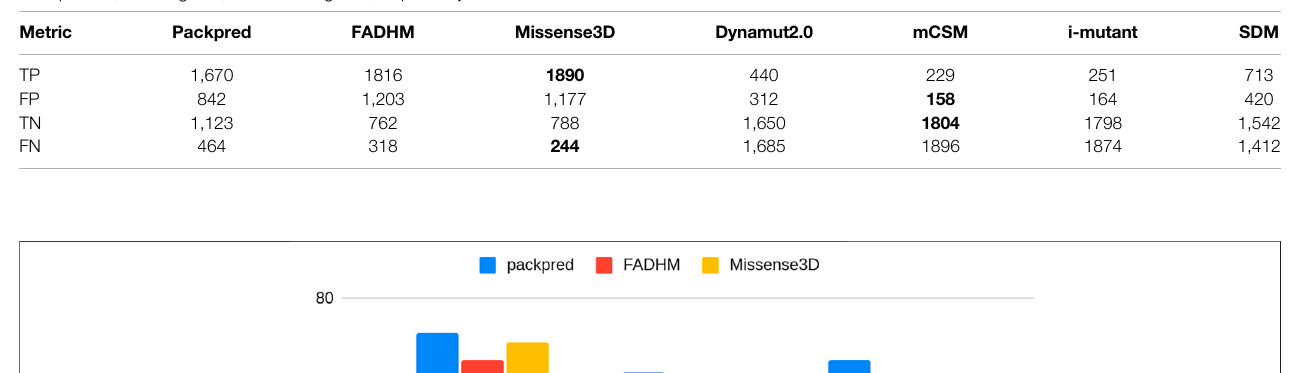
Frontiers in Molecular Biosciences |